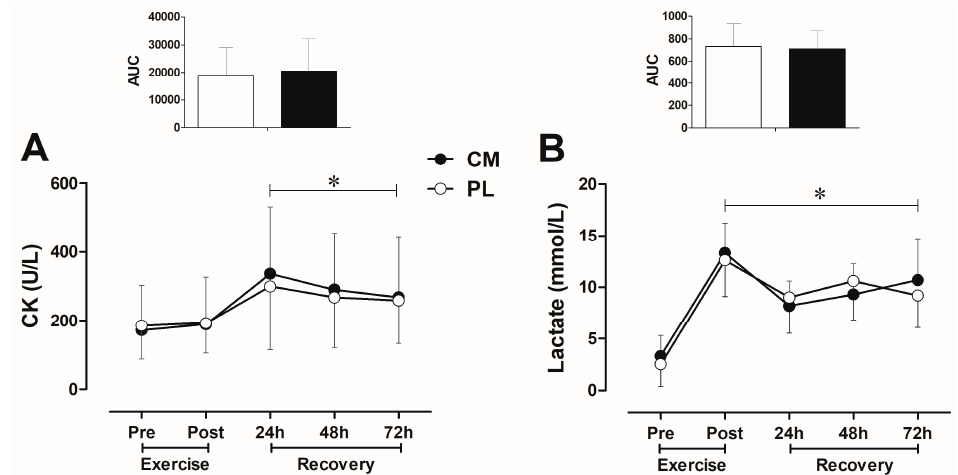
Figure 3. Blood CK ( A ) and lactate ( B ) levels at pre- and post-exercise session, and immediately after fatigue tests during recovery (at 24, 48, and 72 h post-exercise). Citrulline malate (CM), Placebo (PL). Upper figure indicates the area under curve (AUC) from pre- to 72 h post-exercise. (Repeated-measures ANOVA: * p < 0.05 compared to pretraining). Data are means ±